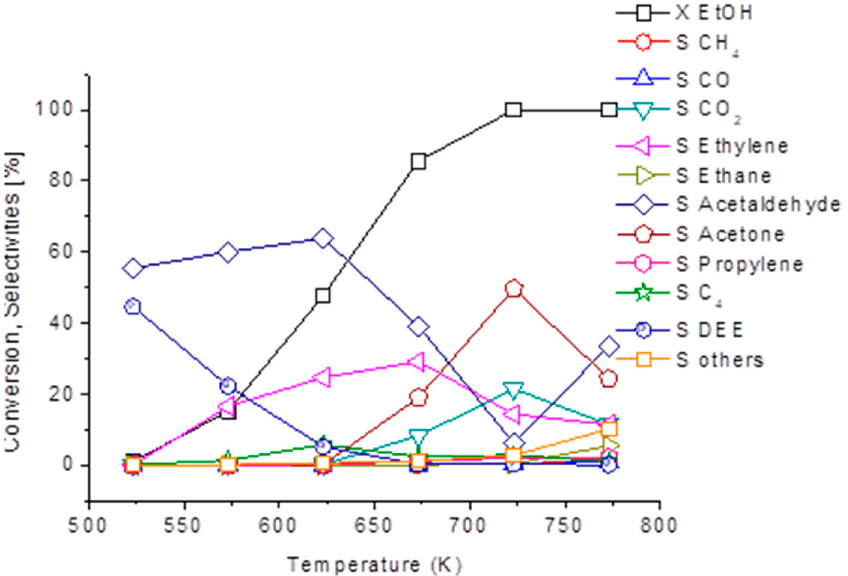
Figure 7. Ethanol conversion and selectivity to products over the ZnO catalyst. Experimental conditions: 7% ethanol, 0.9% water, N 2 balance. Total flow rate 40 NmL/min, catalysts weight 0.25 g.